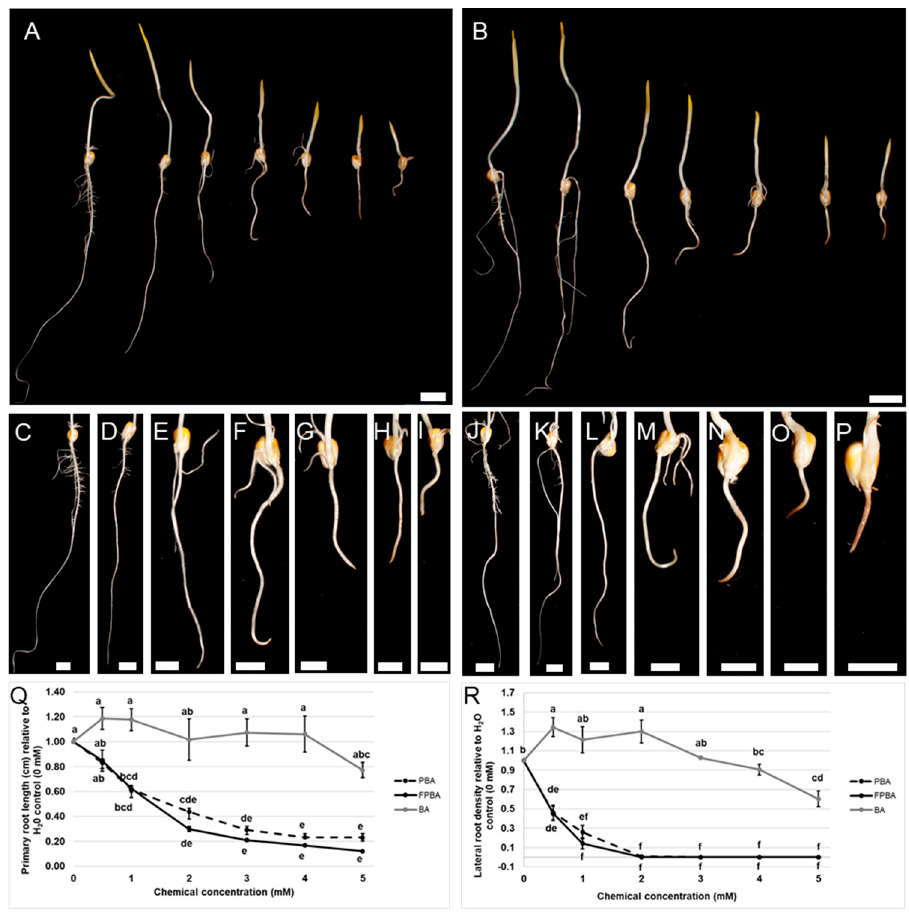
Figure 2. Phenotypes of maize root growth (B73 inbred) germinating in different concentrations of PBA and FPBA. ( A ) Maize B73 seedlings five days after germination in varying concentrations of PBA (from left to right: H 2 O, 0.5 mM, 1 mM, 2 mM, 3 mM, 4 mM, and 5 mM). ( B ) Maize B73 seedlings five days after germination in varying concentrations of FPBA (from left to right: H 2 O, 0.5 mM, 1 mM, 2 mM, 3 mM, 4 mM and 5 mM). C – I ) close up of B73 roots five days after germination in H 2 O ( C ), 0.5 mM PBA ( D ), 1 mM PBA ( E ), 2 mM PBA ( F ), 3 mM PBA ( G ), 4 mM PBA ( H ) and 5 mM PBA (I). J – P ) Close up of B73 roots five days after germination in H 2 O ( J ), 0.5 mM FPBA ( K ), 1 mM FPBA ( L ), 2 mM FPBA ( M ), 3 mM FPBA ( N ), 4 mM FPBA ( O ), and 5 mM FPBA ( P ). ( Q ) Statistical analysis of primary root length of B73 seedlings grown in varying concentrations of PBA, FPBA or BA. ( R ) Statistical analysis of lateral root density of B73 seedlings grown in varying concentrations of PBA, FPBA, or BA. Different letters indicate statistical significance at p < 0.05 according to ANOVA and a post-hoc Tukey test. Scale bar in A, B = 2 cm and in C–P = 1 cm.